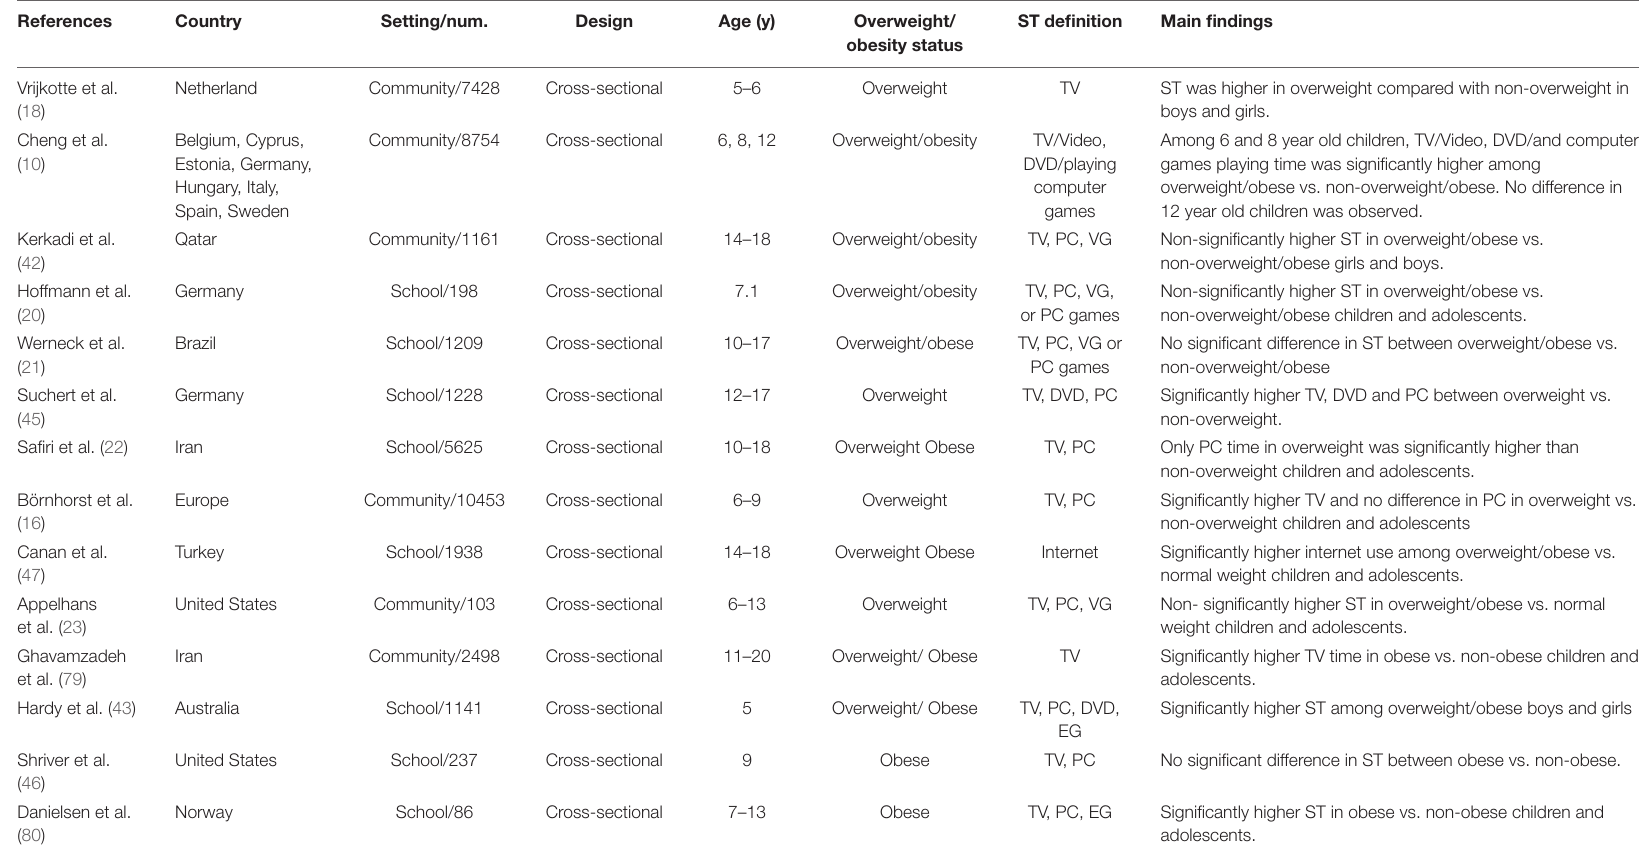
TABLE 2 | The characteristics of studies that were included in the two-class meta-analysis of comparison of screen time between overweigh/obese vs. non-overweight/obese